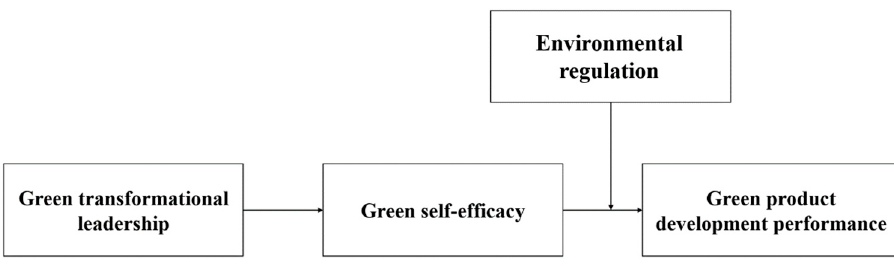
Figure 1. The hypothetical framework.